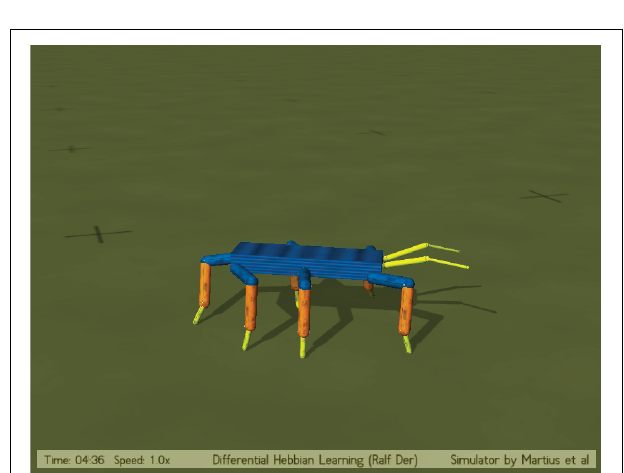
FIGURE 6 | The Hexapod .